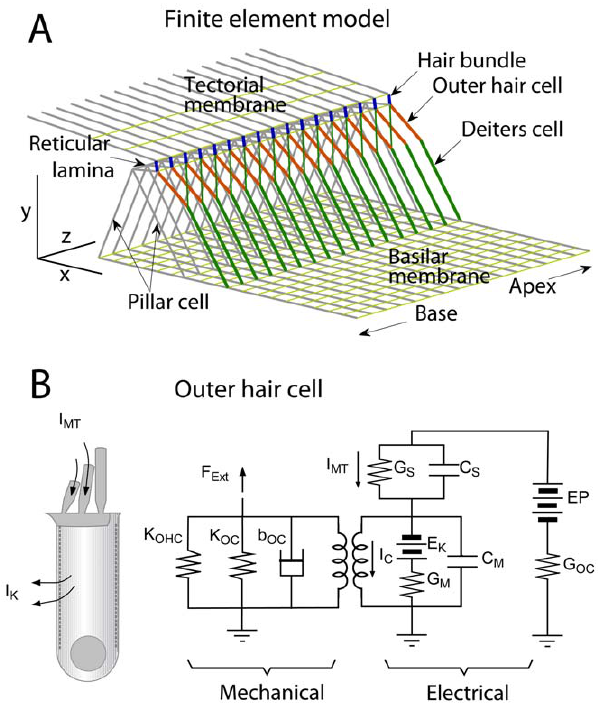
Figure 1. Cochlear partition model. ( A ) 3D finite element model of the cochlear partition. ( B ) Electrical representation of an OHC and its piezoelectricity. For illustrative purpose, the mechanical system around the OHC was expressed with K OHC , K OC and b OC that correspond to OHC stiffness, stiffness of OC without OHCs, and viscous damping in the OC. In the analysis, the finite elements in A represent the mechanical part. Key electrical parameters are maximum mechanotransducer conduc- tance, G S =27, 90 nS, K + conductance across basolateral membrane, G M,max =45, 370 nS at the two cochlear locations; Membrane capaci- tance of basolateral membrane, C M , is six time greater than C S , membrane capacitance of stereociliary membrane, C M =15, 4.3 pF, for apex and base respectively; K + equilibrium potential, E K =70 mV and endocochlear potential, EP =90 mV.